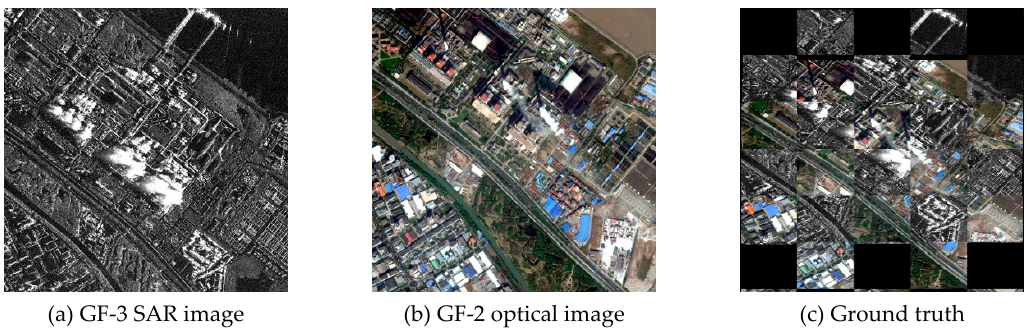
Figure 4. The original simulated data and the ground truth for the GF-3 and GF-2 images.